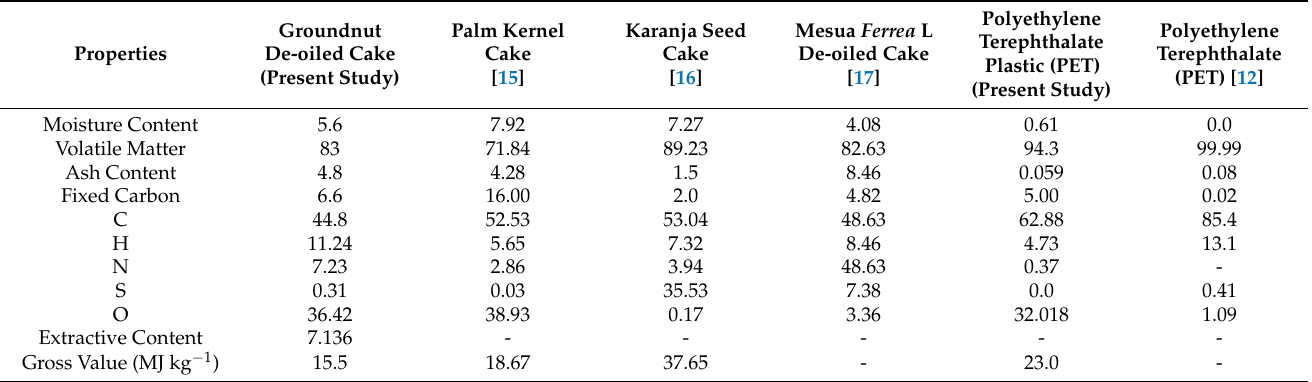
Table 2. Comparison of the Proximate/Ultimate characteristics of the present study with the existing